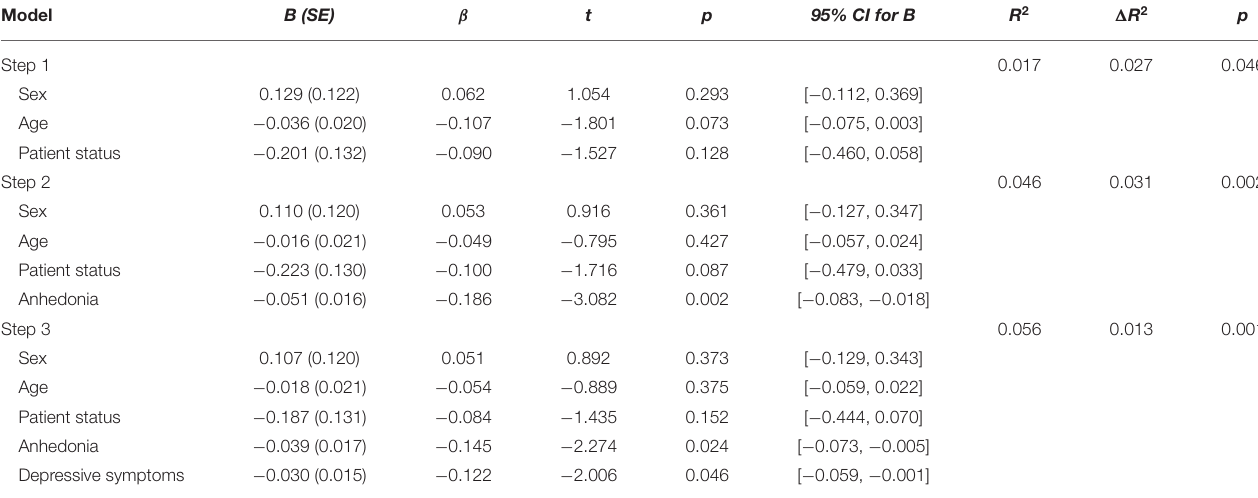
TABLE 4 | Regression analysis: social quality of life.